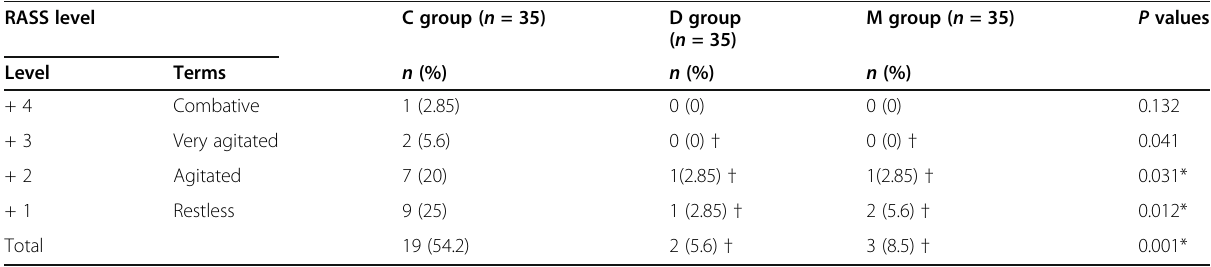
Table 2 Incidence of emergence agitation among studied